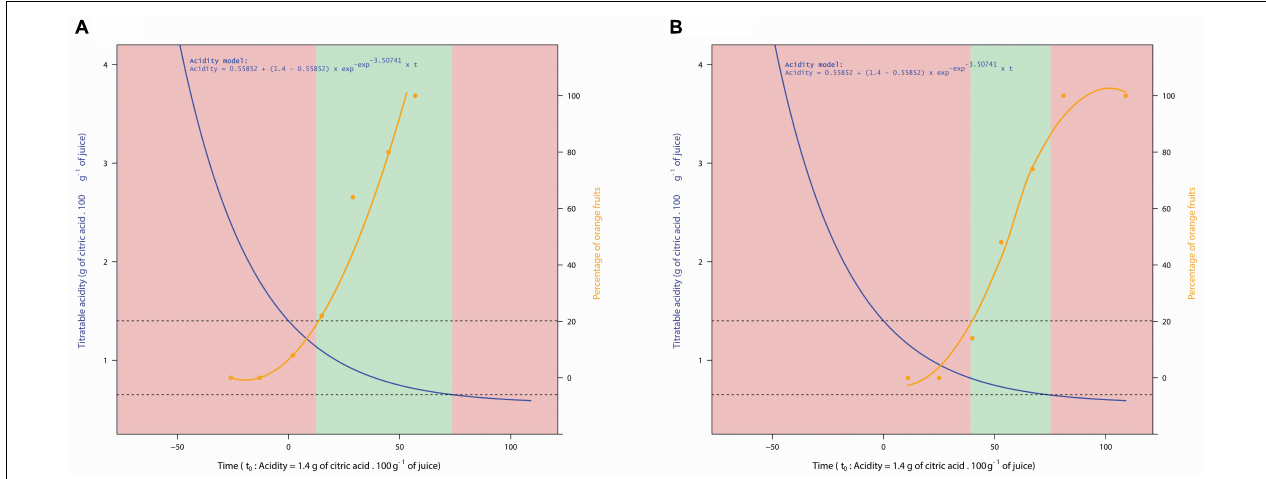
FIGURE 5 | Graphical representation of harvestability windows (green) determined by the acidity drop model (blue line) and fruit coloration (orange line) on two contrasting plots in 2014: 19003 (A) and 3202a (B) . The left ordinate corresponds to the values of acidity relative to the model. The right ordinate corresponds to the percentage of orange fruits relative to the coloring curves. The harvestability window is represented by the green zone corresponding to the optimum fruit maturity regarding to PGI “Corsican Clementine” (European Union,